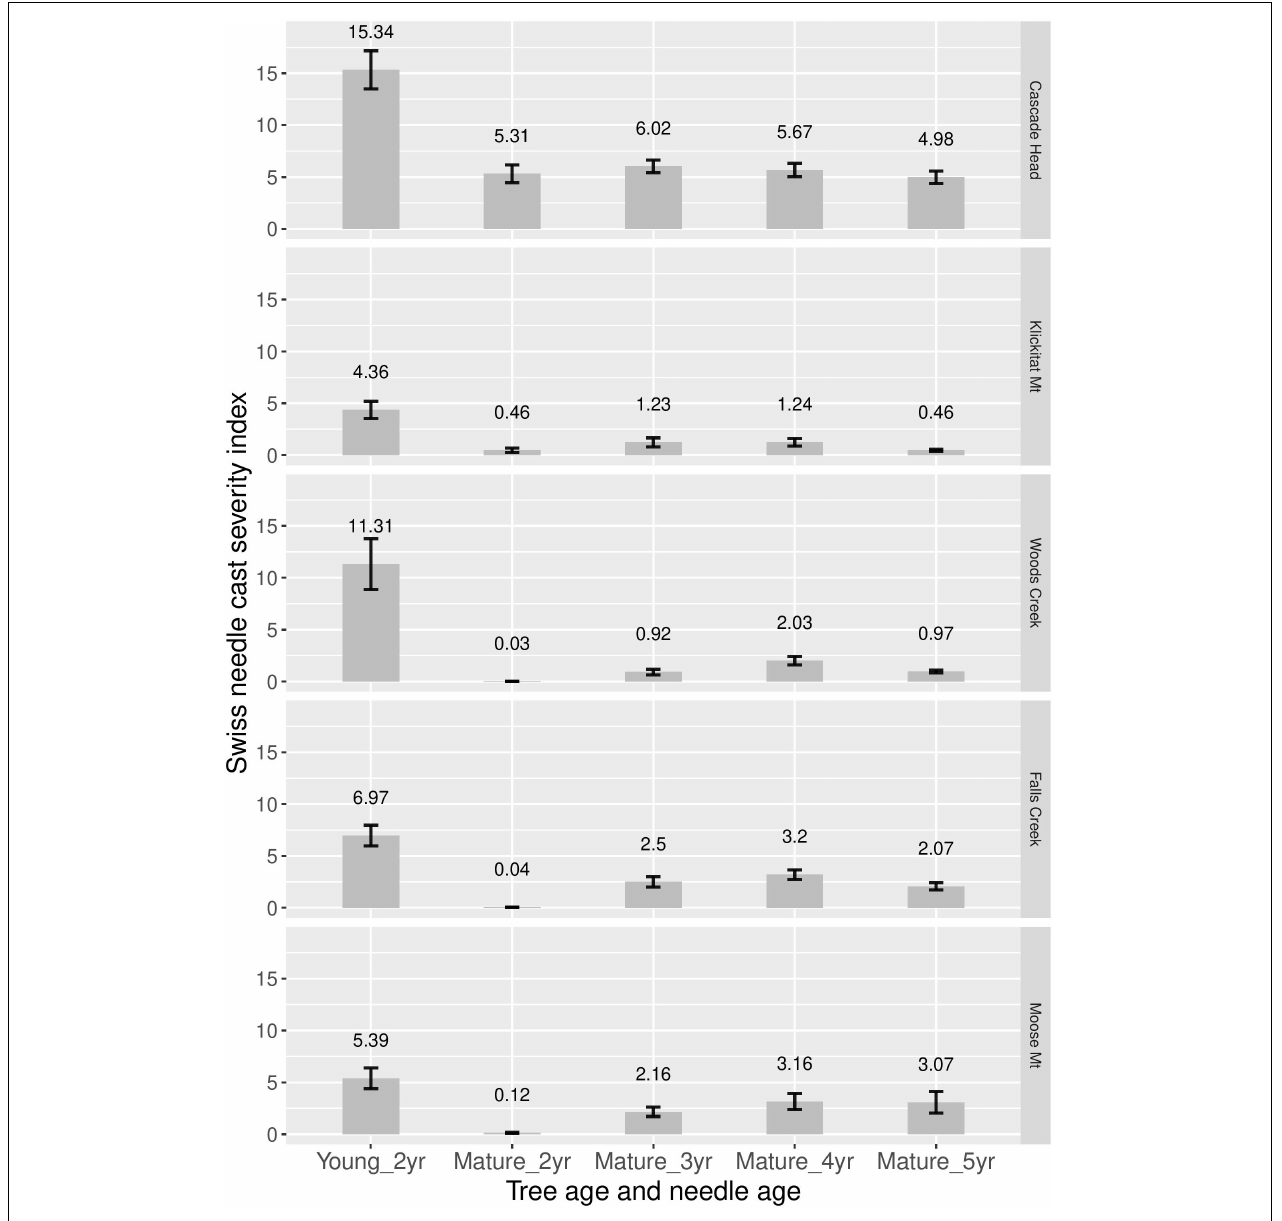
FIGURE 4 | Swiss needle cast average disease severity (incidence × density) for 2-year-old needles in young nearby plantations, and for 2, 3, 4, and 5-year old needles in mature stands. Two years and three canopy positions were averaged at each